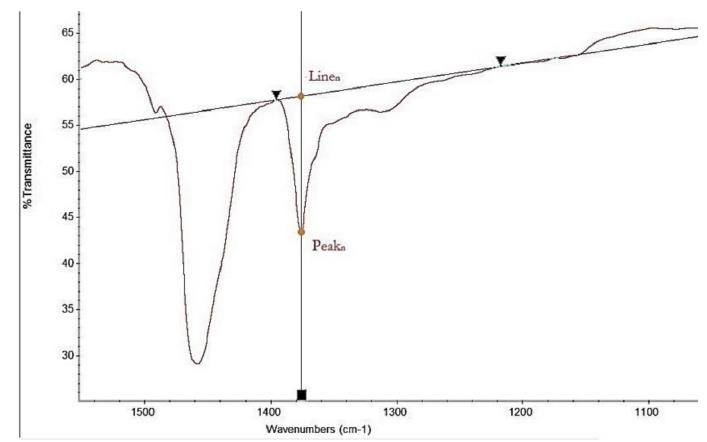
Figure 5. Example determination of Line n and Peak n percent